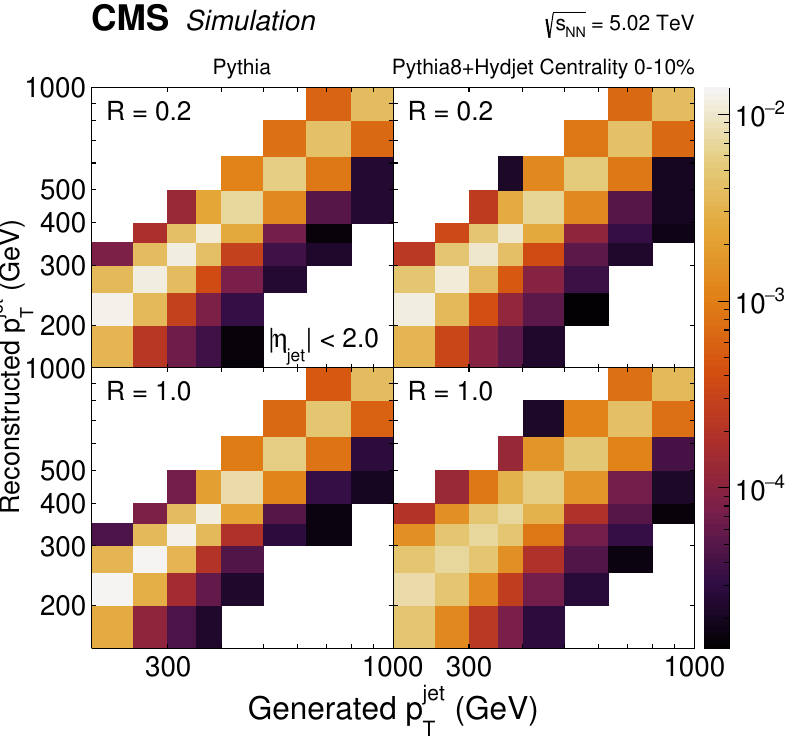
Figure 3 . Response matrices in pythia (left) and pythia + hydjet 0–10% PbPb (right) events for jets reconstructed with R = 0 . 2 (upper), R = 1 . 0 (lower) and | η jet | < 2 . The integral for each generated p jet bin is normalized to T